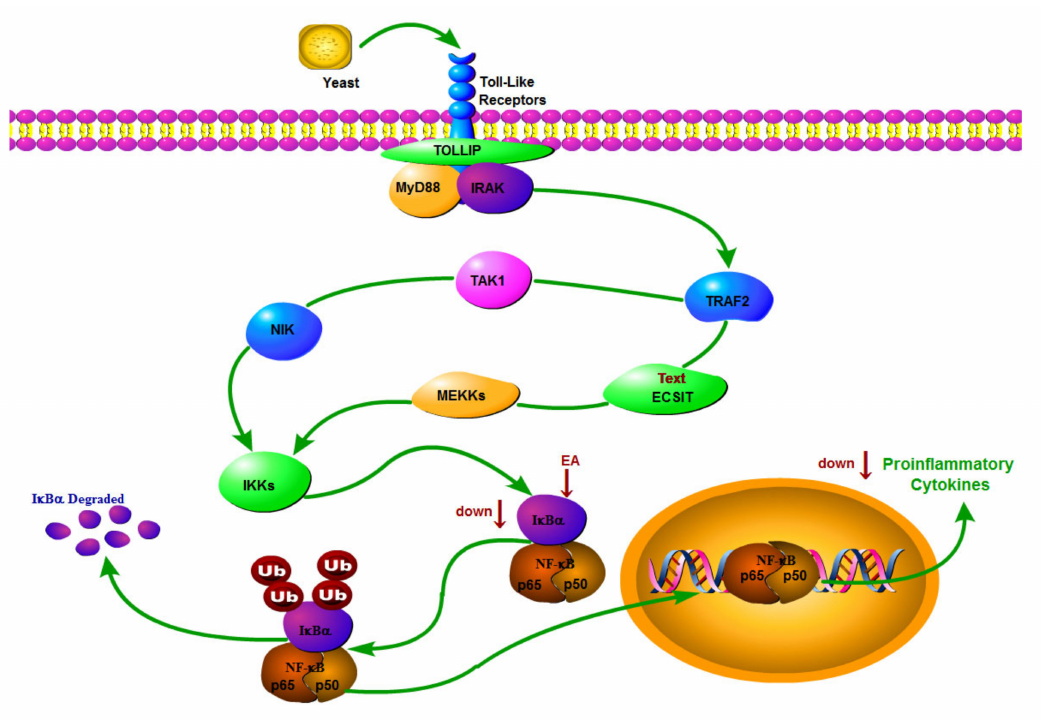
Figure 9. EA plays an antipyretic and anti-inflammatory role by regulating IKB- α /NF- κ B pathway and inhibiting inflammatory factors.